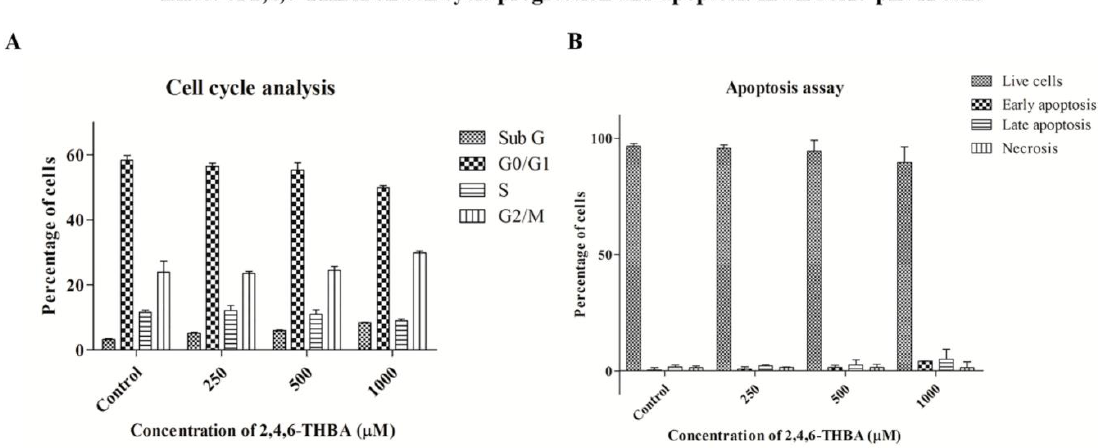
Figure 8. Graphic representation of ( A ) the cell cycle analysis and ( B ) apoptosis assay following treatment with 2,4,6-THBA in SLC5A8-pLVX cells. The percentage of cells in each stage was determined through flow cytometry.